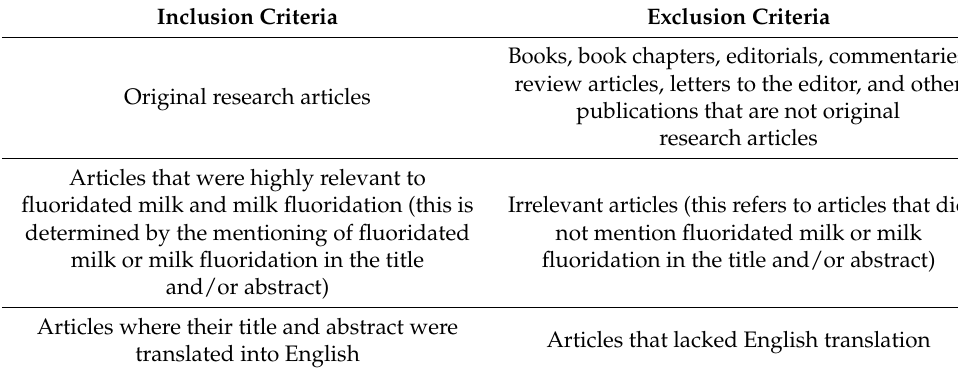
Table 1. Selection